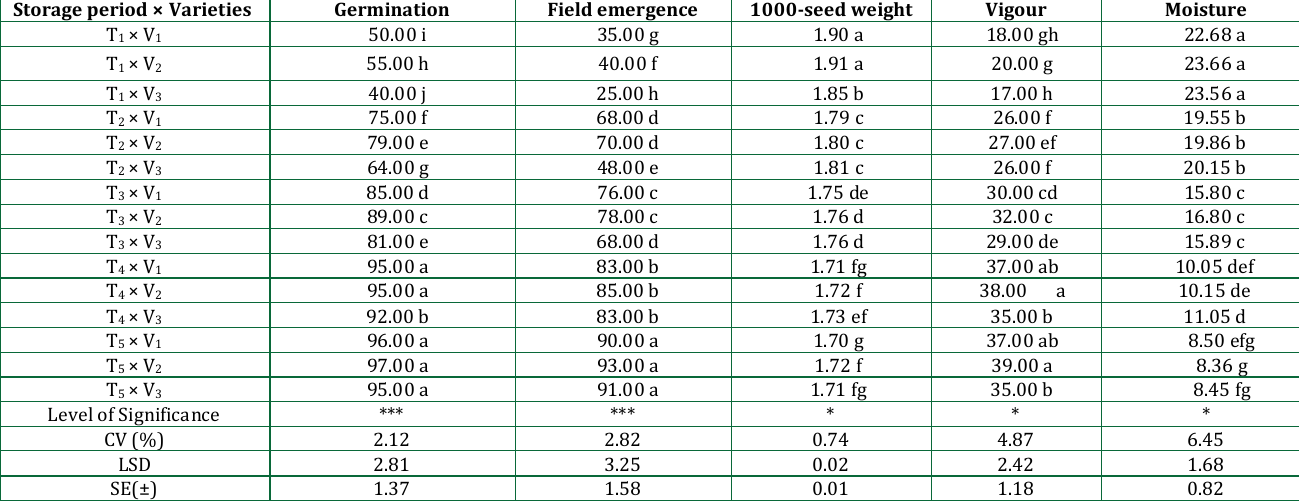
Table 3: Effect of Storage period × Varieties interaction on tossa jute ( Corchorus olitorius L.) seed qualities Storage period × Varieties